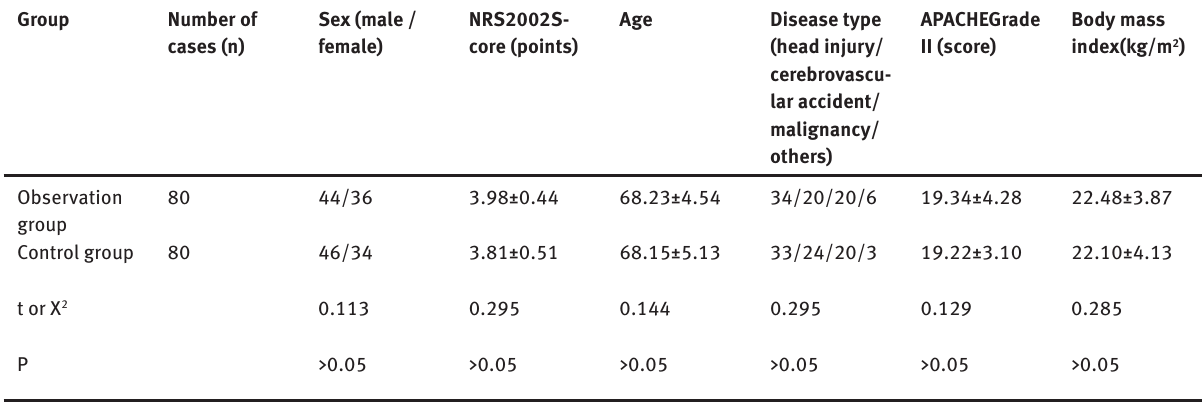
Table 1: Baseline data comparison between the two groups